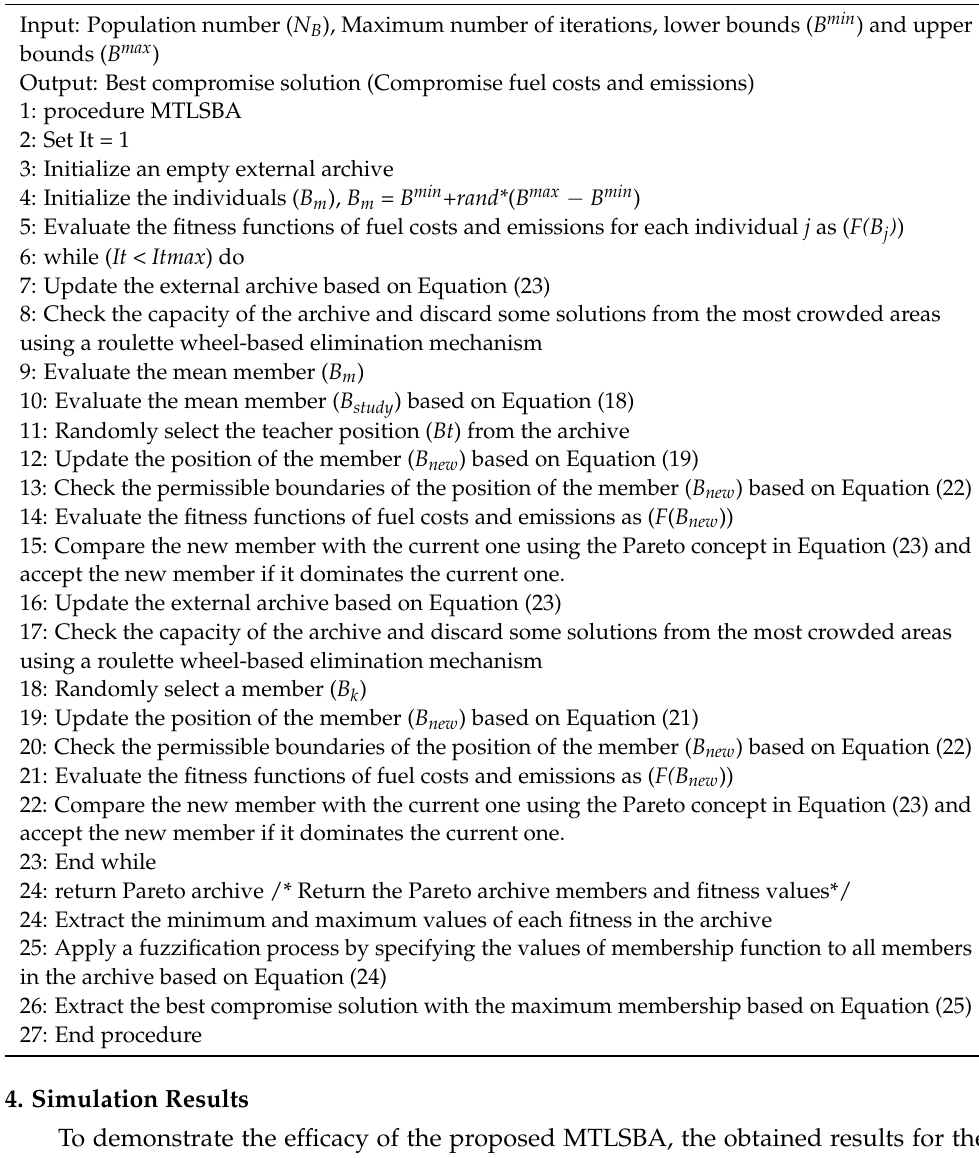
Algorithm 1 Pseudocode of the proposed MTLSBA to solve the CHPEED